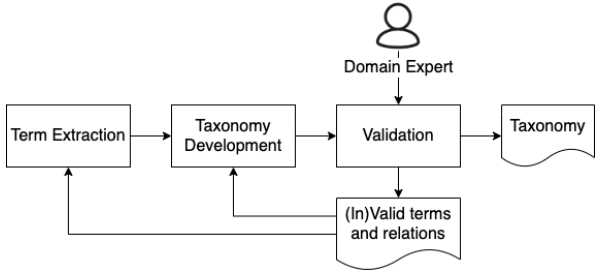
Figure 1. Human-in-the-loop taxonomy development